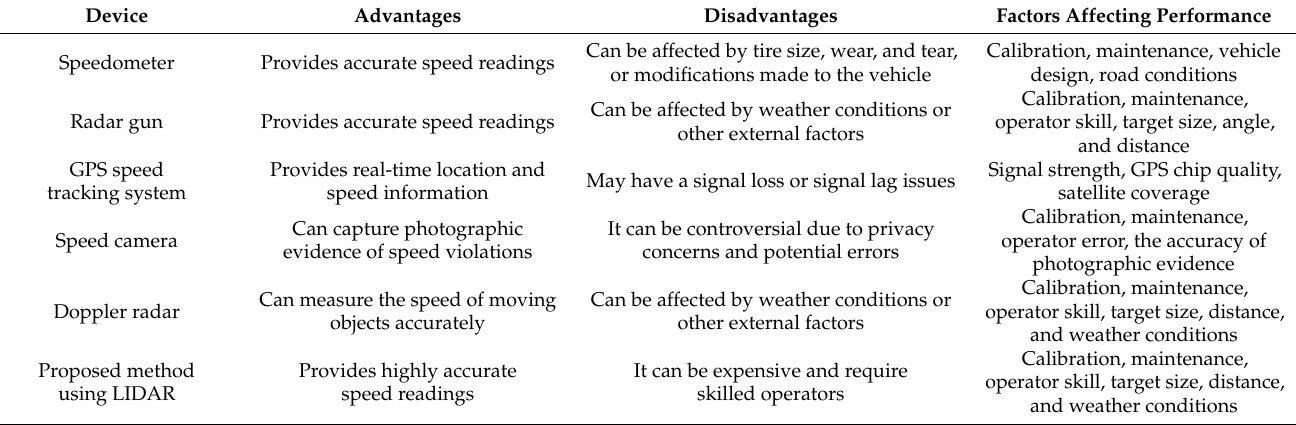
Table 2. Comparison of conventional velocity measuring devices with the proposed velocity mea- surement method using